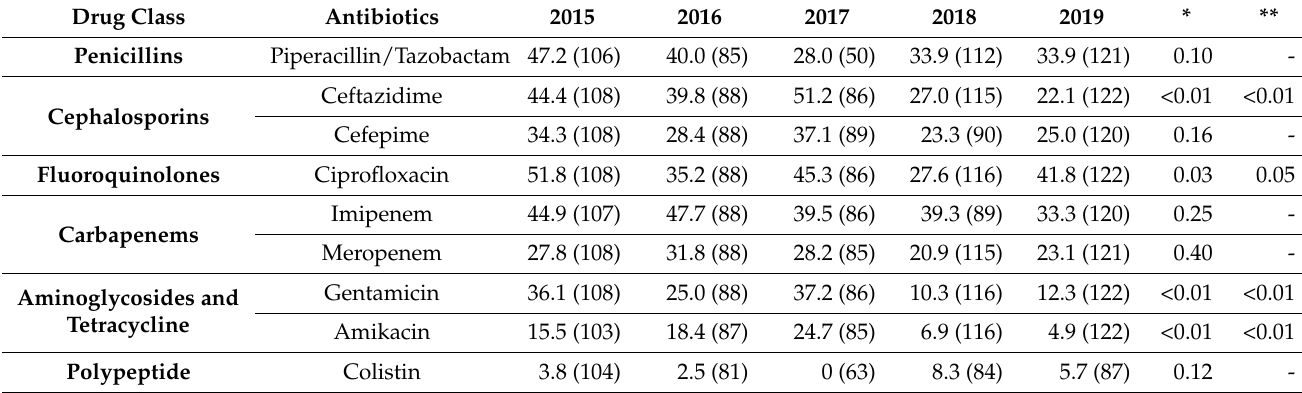
Table 6. Antimicrobial resistance profile of Pseudomonas aeruginosa to antibiotics used in